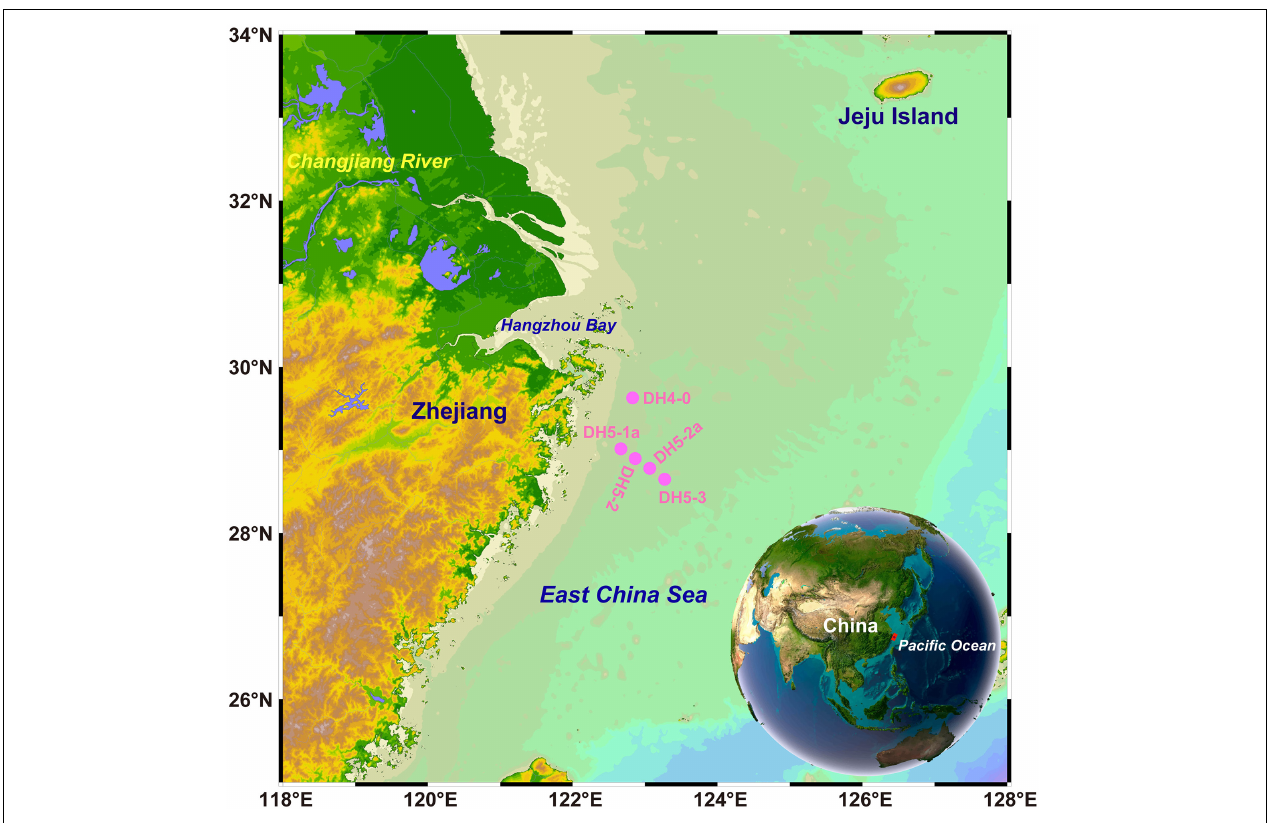
FIGURE 2 | Sampling sites (pink dots) in the East China Sea (ECS) during